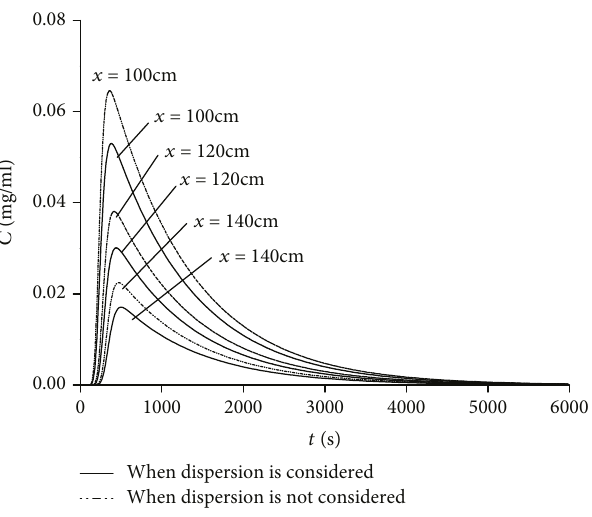
Figure 1: Relationship between particle concentration and time for various distances predicted by equations (18) (solid curves) and (19) (dashed curves), using parameters given in Table 1. Table 1: Model parameters used for simulations shown in Figures 1 and 2.